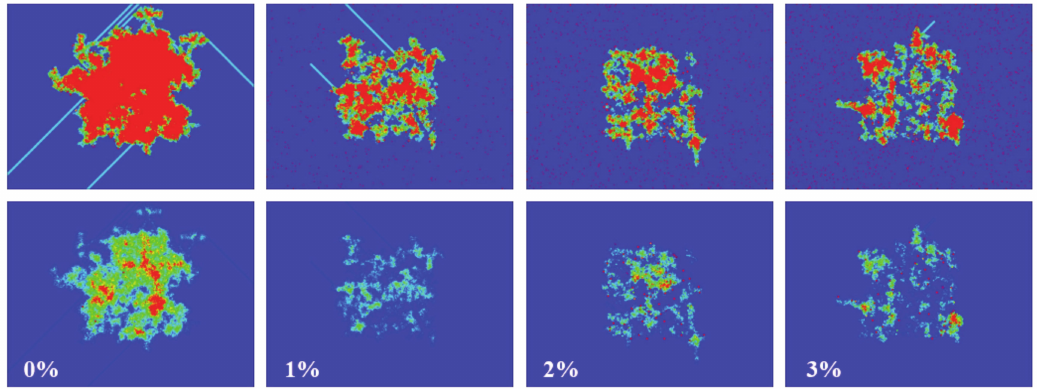
Figure 14. (Color online) Top panel: Activated Area after 1000 steps for initial density = 15%. Bottom panel: Spiked Area applying Rule 4 (scale goes from 0 (dark blue) to 20 (red)). From left to right, the percentage of defects is 0%, 1%, 2%, and 3% as